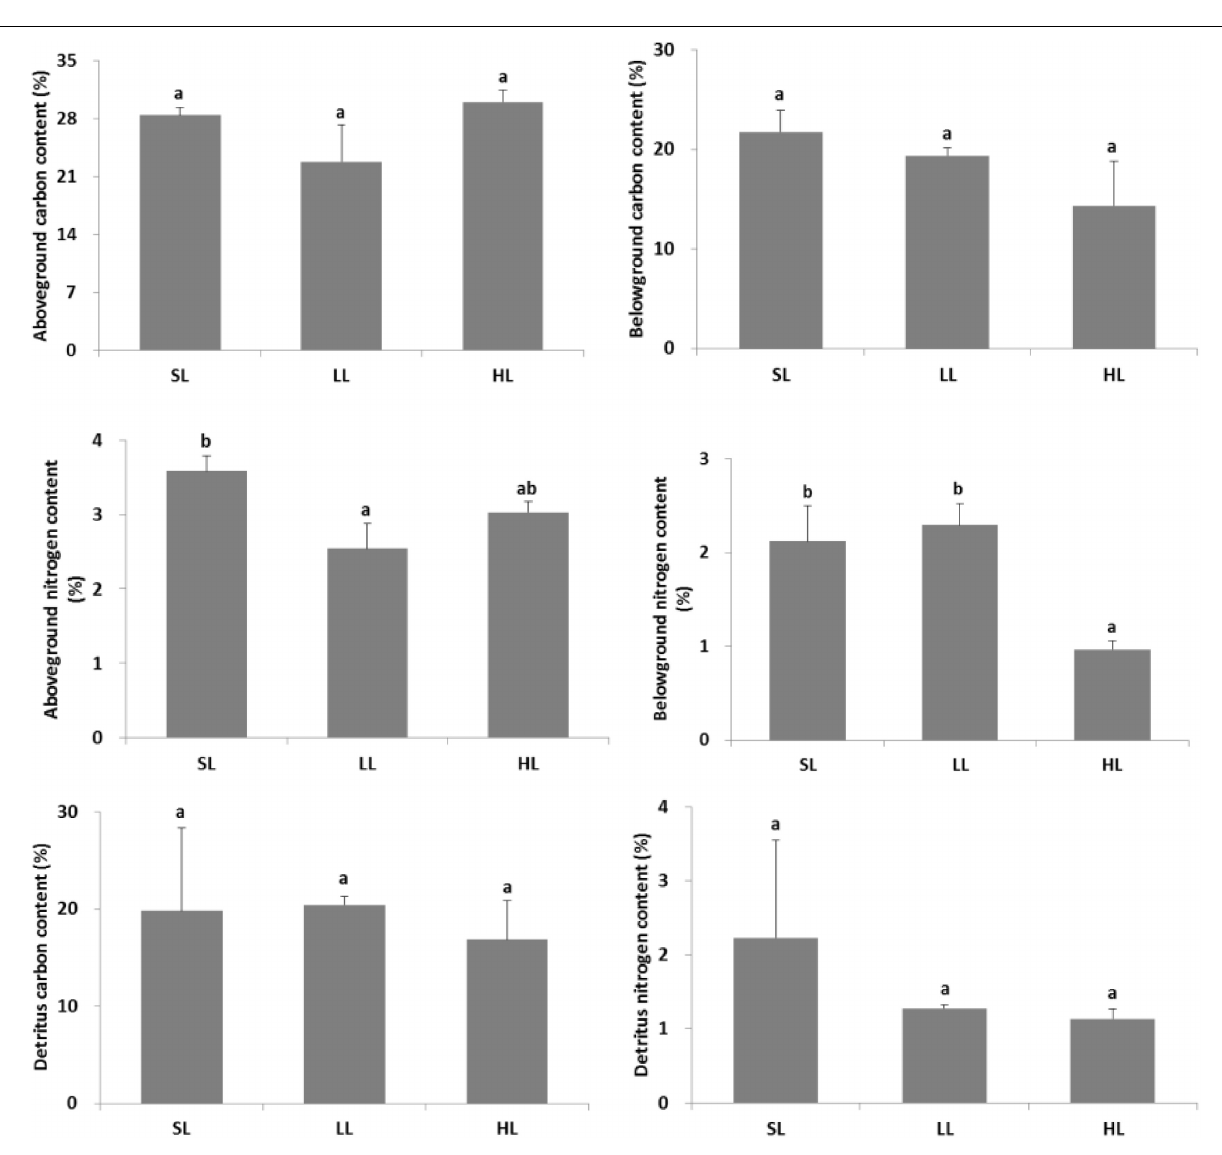
Frontiers in Plant Science |